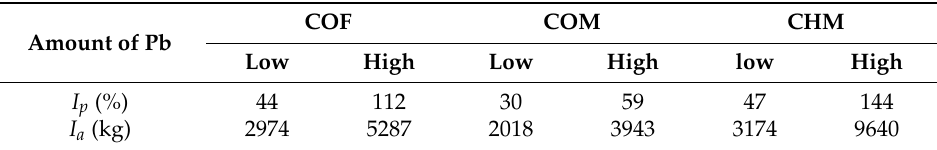
Table 5. Estimated increase in the amount of Pb ingested through vegetable consumption due to the increased concentration in the edible parts of Brassica chinensis resulting from the addition of DOM to the soil. COF COM CHM Amount of Pb Low High Low High low High I p (%) 44 112 30 59 47 144 I a (kg) 2974 5287 2018 3943 3174